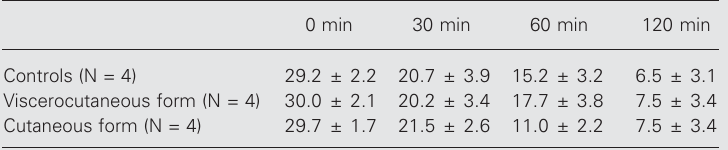
Table 1. Hydrolysis of red blood cell ghost band 3 from patients with the viscerocutaneous and the cutaneous forms of loxoscelism caused by venom from the Loxosceles gaucho spider.